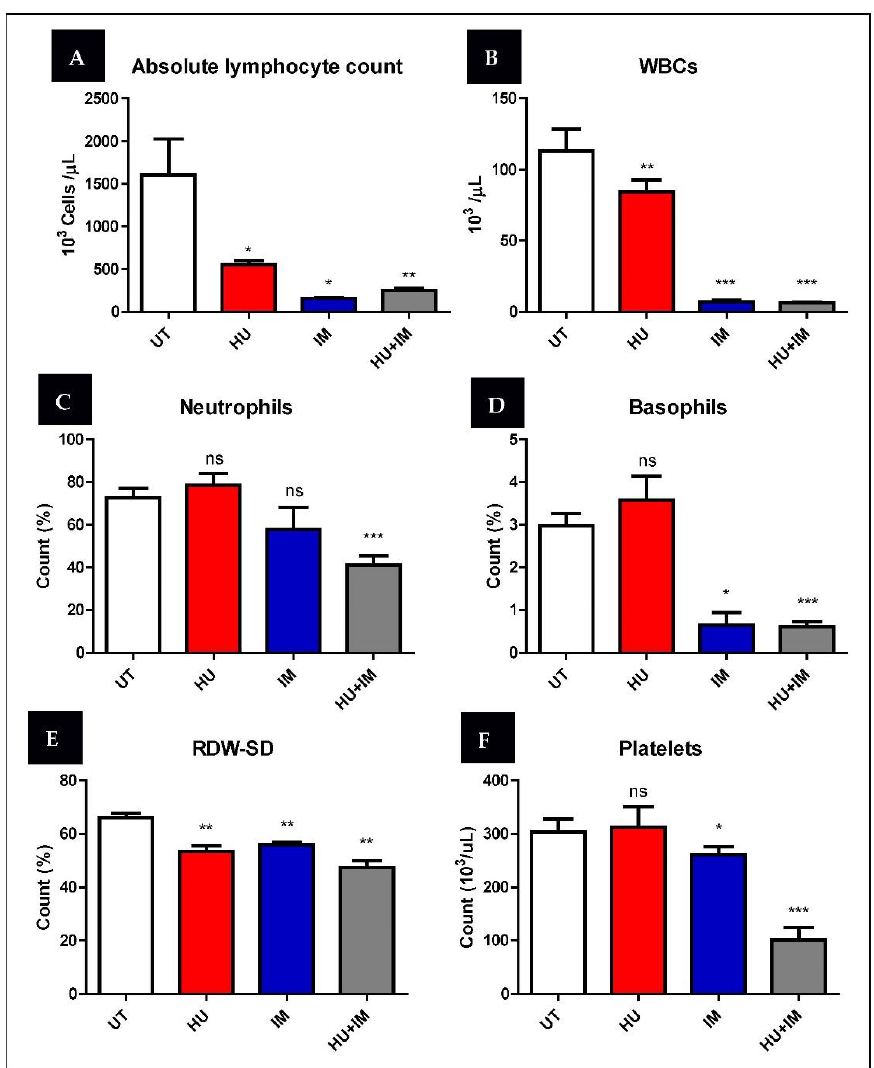
Figure 6. Hematological parameter changes due to IM, HU, IM, and HU treatment of CML patients. ( A ) absolute lymphocyte count; ( B ) WBC’s; ( C ) neutrophils; ( D ) basophils; ( E ) RDW-SD; ( F ) platelets. Two-tailed paired t -test was performed and the statistical difference between the untreated and treated patients is shown in the figures (* p < 0.05, ** p < 0.01, *** p < 0.005).